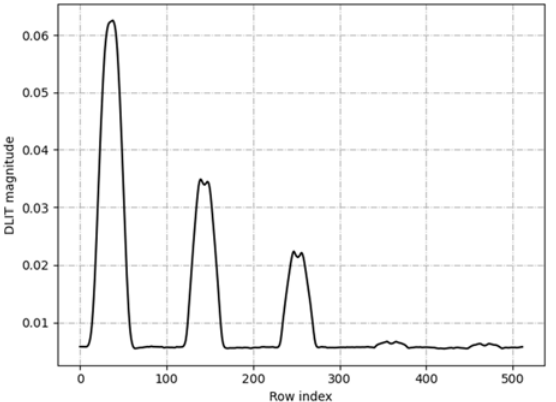
Figure 15. Intensity plot after applying 15 × 15 average filter.